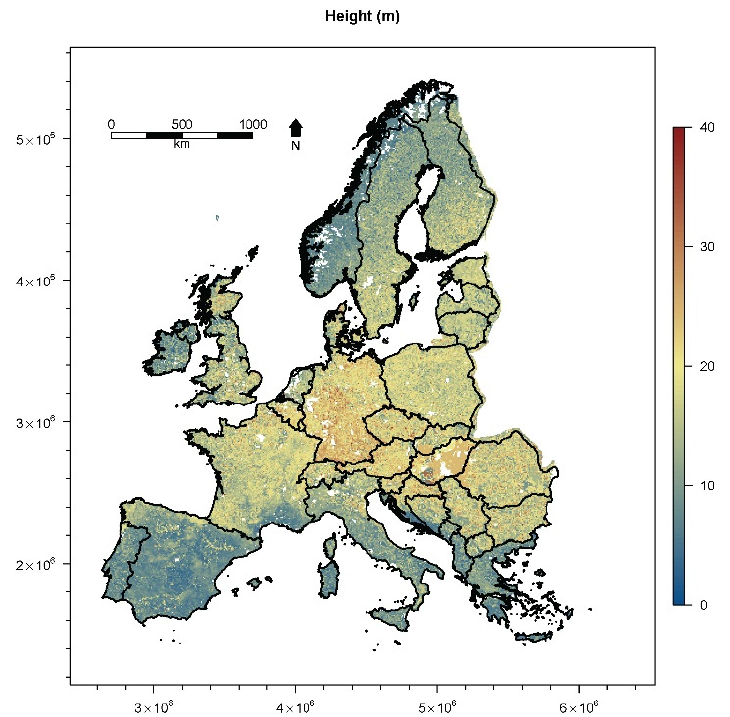
Figure 6. Mean tree height (m) for vegetated 8 × 8 km cells. For details, see Figure 3.